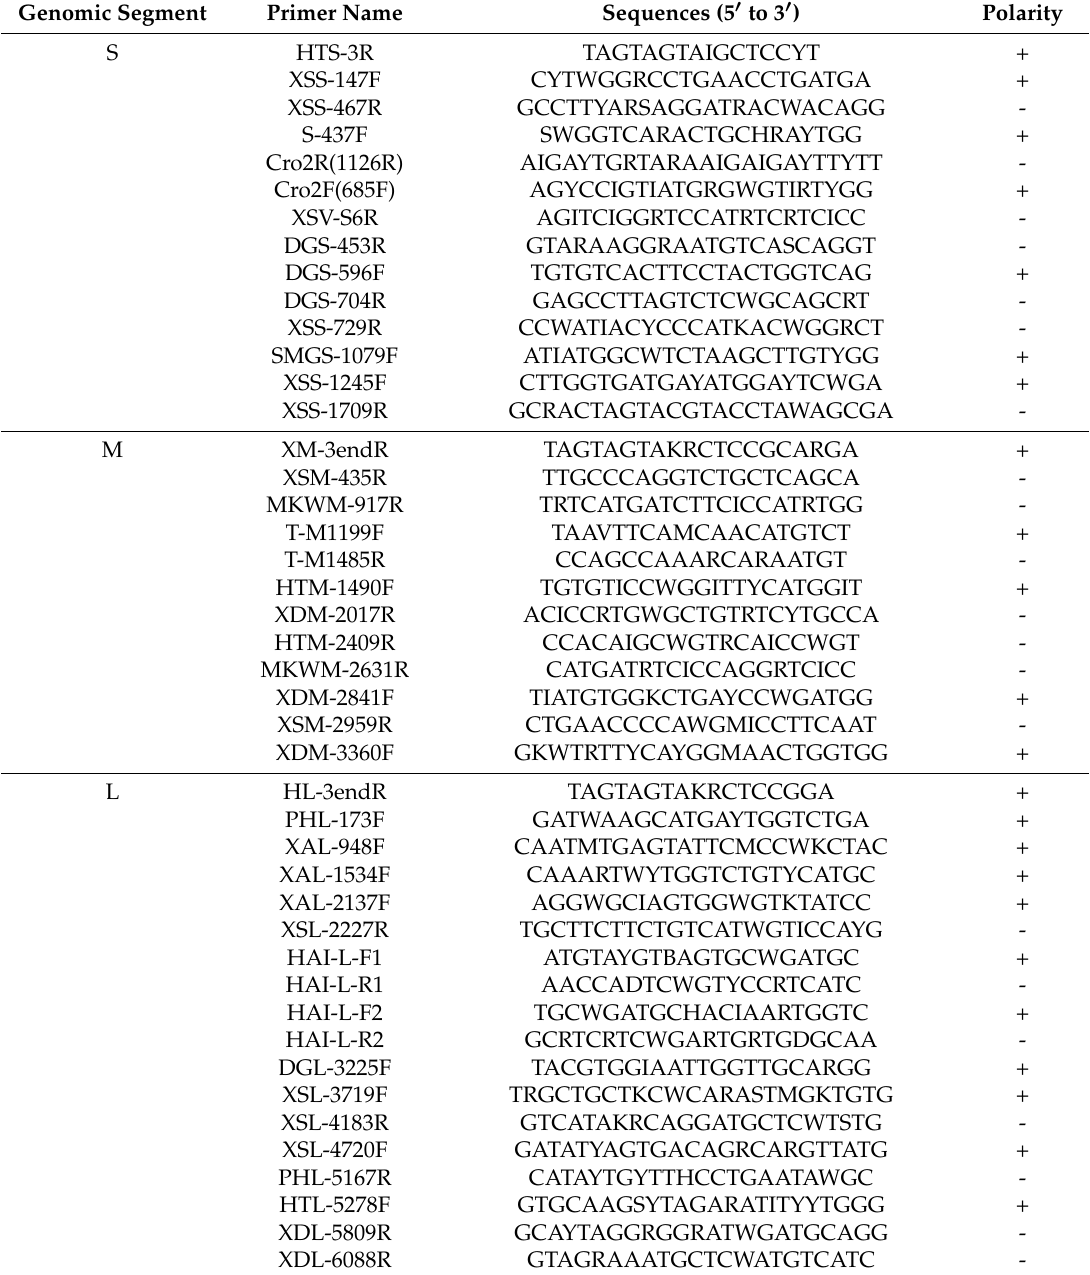
Table 1. Oligonucleotide primers used to amplify mobatvirus RNA from the lung tissues of bats. Genomic Segment Primer